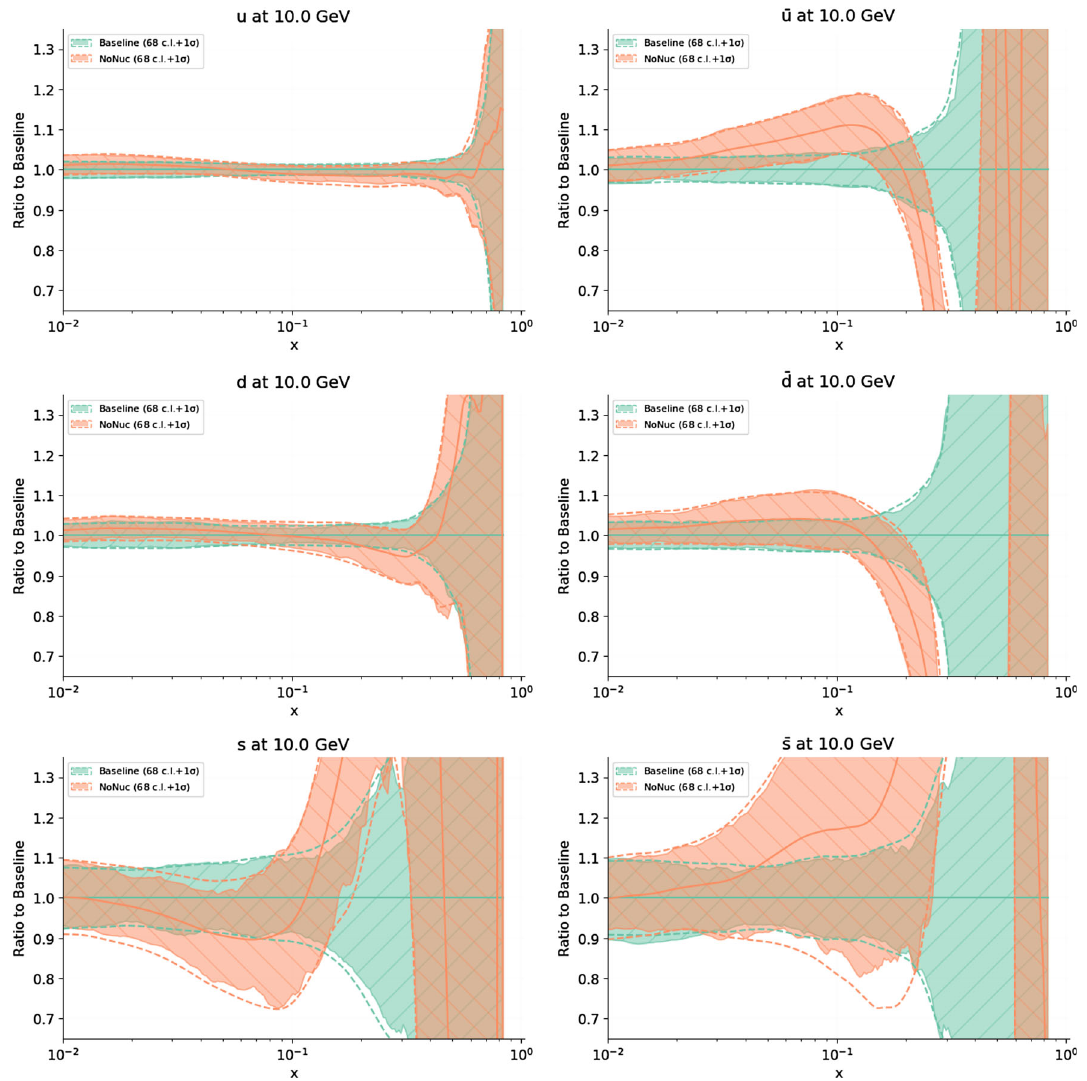
Fig. 10 Comparison between the Baseline fit, and the fit without any data on nuclear targets, NoNuc. The light quark (left) and antiquark (right) flavours are shown at Q = 10 GeV. Results are normalised to the Baseline fit